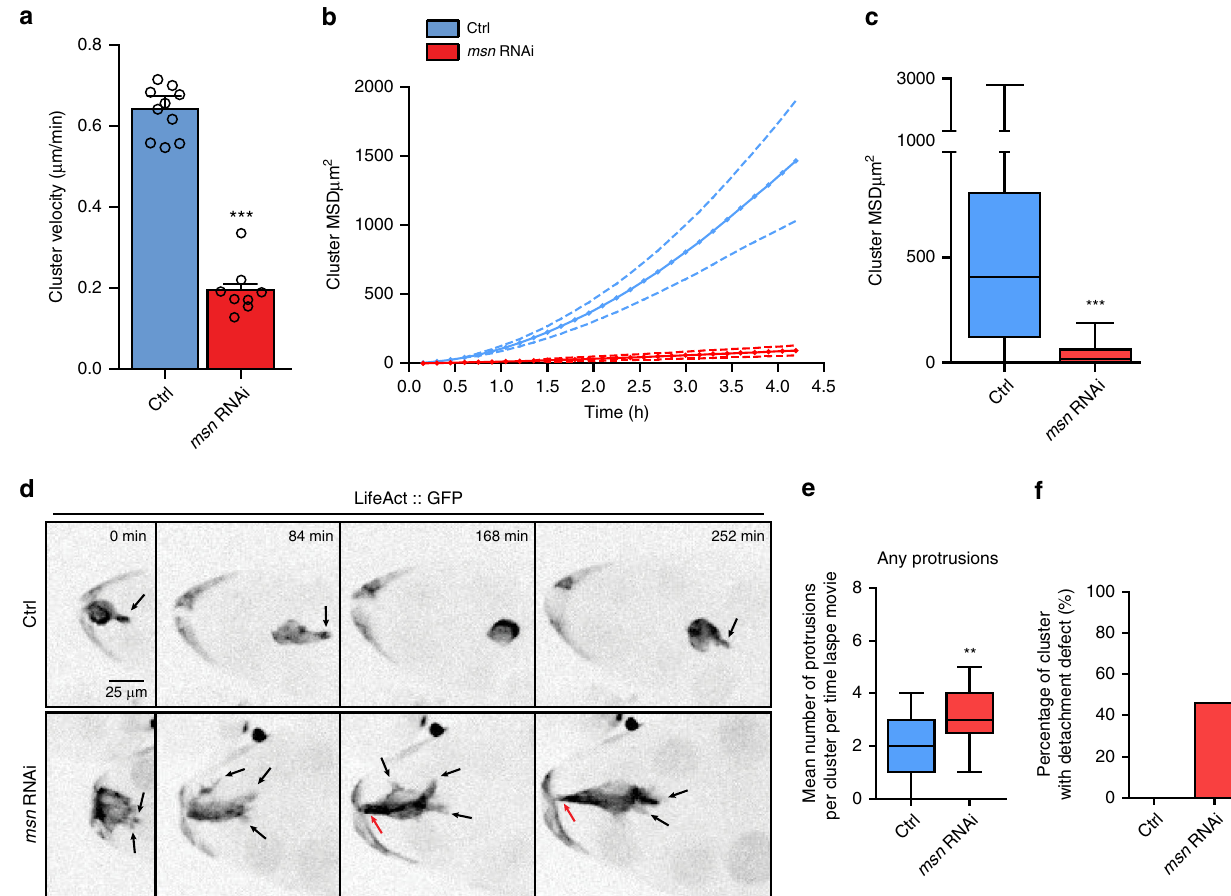
Fig. 2 Msn is required for BC migration, protrusion restriction and detachment. a Quanti fi cation of cluster velocity of control ( n = 10) and Msn-depleted clusters ( n = 8) from live imaging. *** p < 0.001, unpaired Student ’ s t -test. The error bars show s.e.m. Quanti fi cation of the mean square displacement (MSD) over time in b and cumulative in c of control ( n = 10) and Msn-depleted clusters ( n = 8) from live imaging. *** p < 0.001, two ways ANOVA test. On box plots, the box limits represent the fi rst (lower) and the third (upper) quartile values, the whiskers show the smallest and the greatest values; and the center line represents the median. n represents the numbers of independent BC clusters. d Inverted still greyscale images from a time-lapse recording of clusters expressing LifeAct::GFP in control or Msn-depleted conditions. Black arrows indicate protrusions and red arrows point to the detachment defect (see Movie 2). e Using 2D live imaging, we quantify the number of protrusions per cluster at each time point of 5 h movies of control and Msn-depleted clusters ( n = 8 and 10, respectively). Any protrusions larger than 4 μ m were automatically detected using ADAPT plugin and LifeAct::GFP as a marker. ** p < 0.01, two ways ANOVA test, The error bars show s.e.m. f Quanti fi cation of the percentage of clusters that started to migrate and still have not detached by stage 10 ( fi xed samples) ( n = 47 and 39, for Control and msn RNAi